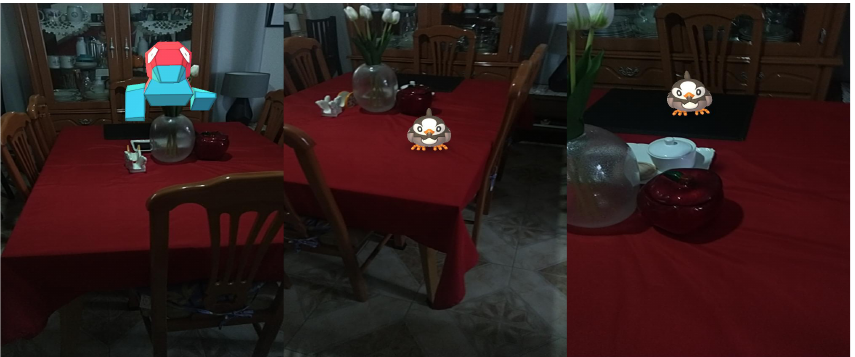
Figure 1. Displays of virtual elements on flat surfaces using the Pokemon Go game. The virtual elements are displayed through obstacles within the scenario that could cause accidents because the user requires interaction with the virtual